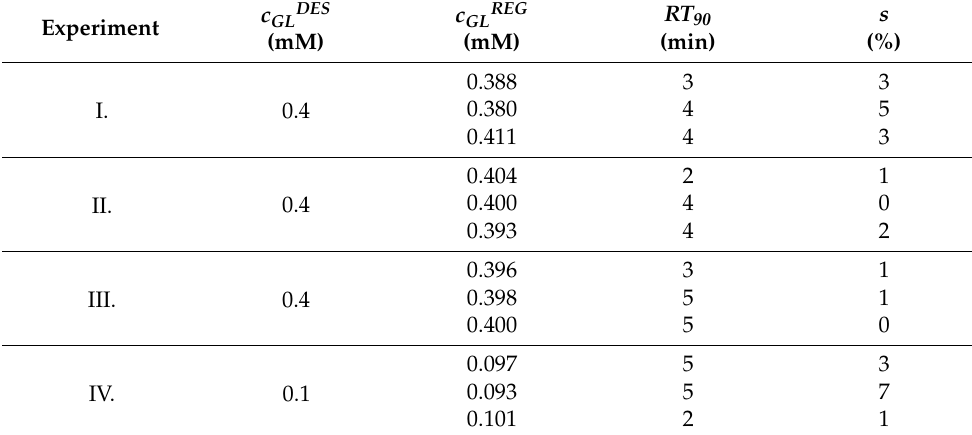
Table 2. Response times of the biosensor and deviations from desired glucose concentration in case of step increase of glucose